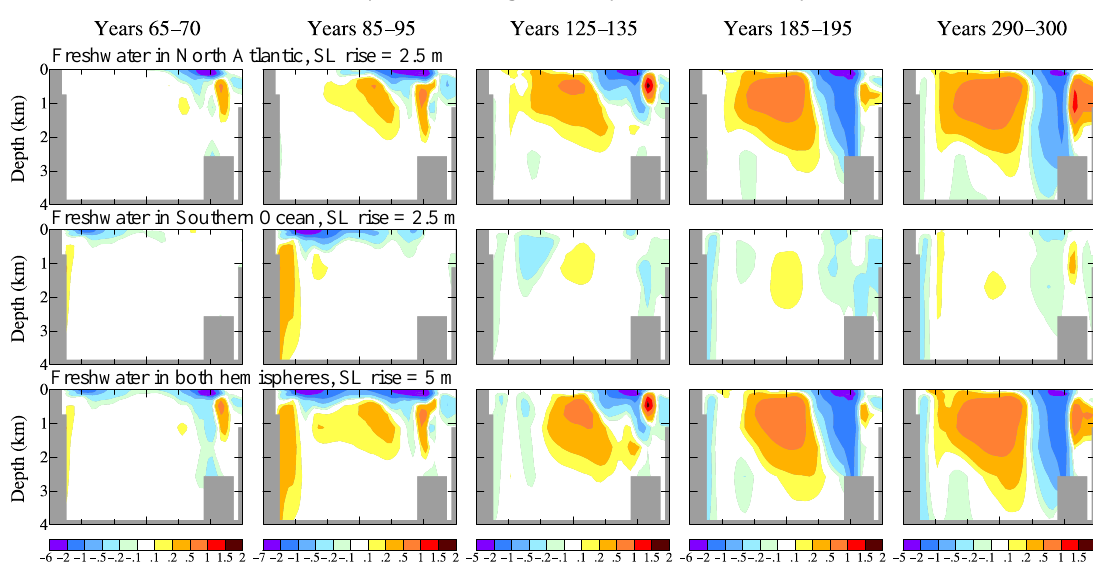
Figure 12. Change of ocean temperature ( ◦ C) relative to control run due to freshwater input that reaches 2.5m of global sea level in a hemisphere (thus 5m sea level rise in the bottom